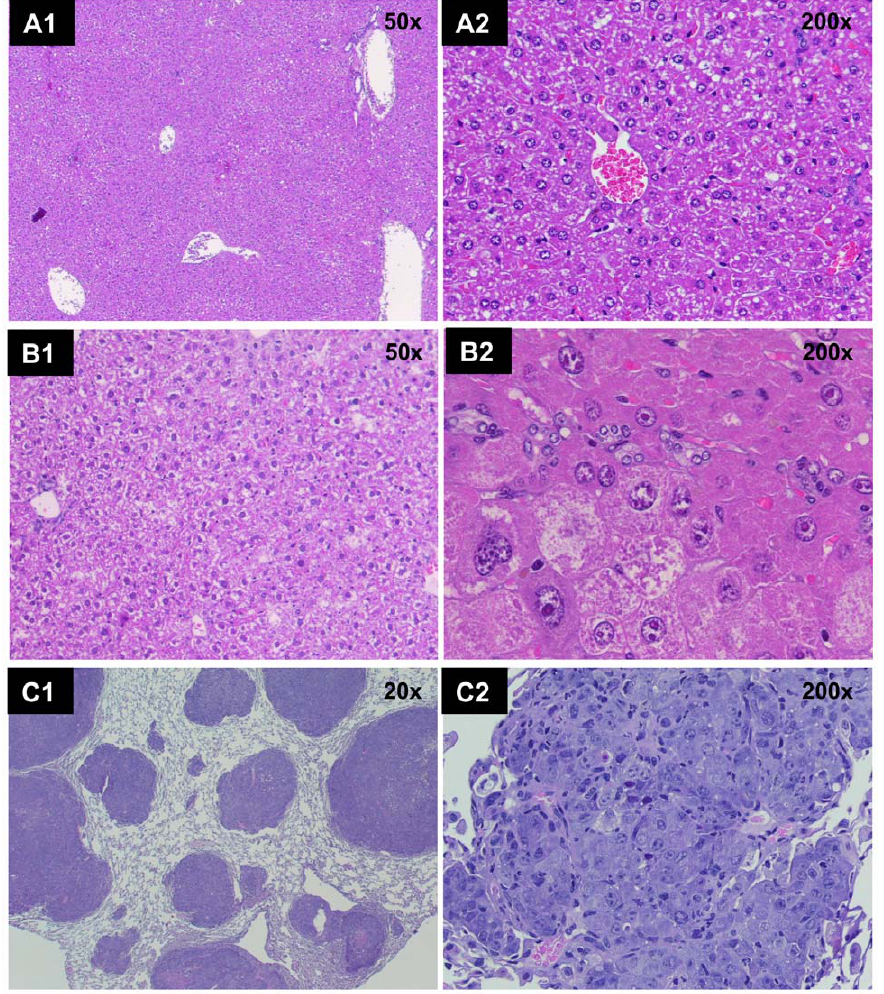
Figure 6. Histopathology of the liver of c-Myc treated transgenic animals. (A) Diffuse liver cell dysplasia of physiological saline (=vehicle) treated transgenic mice at (A1) 50- and (A2) 200-fold magnification. (B) Large cell dysplasia of various degrees in BHT treated animals at (B1) 50- and (B2) 200-fold magnification. (C) Hepatocellular carcinoma of a transgenic mouse treated with the genotoxic carcinogen NDEA at (C1) 50 and (C2) 200- fold magnification.